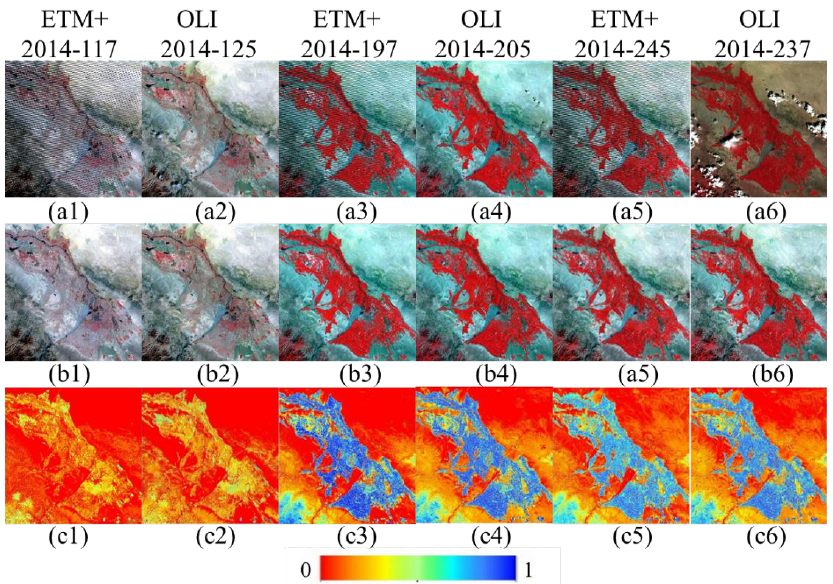
Figure 9. The FVC maps derived from Landsat 7 ETM+ and Landsat 8 OLI reflectance data using the proposed algorithm ( c1 – c6 ). ( a1 – a6 ) The original standard false color composited Landsat proposed algorithm ( c1-c6 ). ( a1-a6 ) The original standard false color composited Landsat images; and ( b1-b6 ) the corresponding standard false color composited Landsat images with cloud and cloud shadow removed as well as gaps filled.